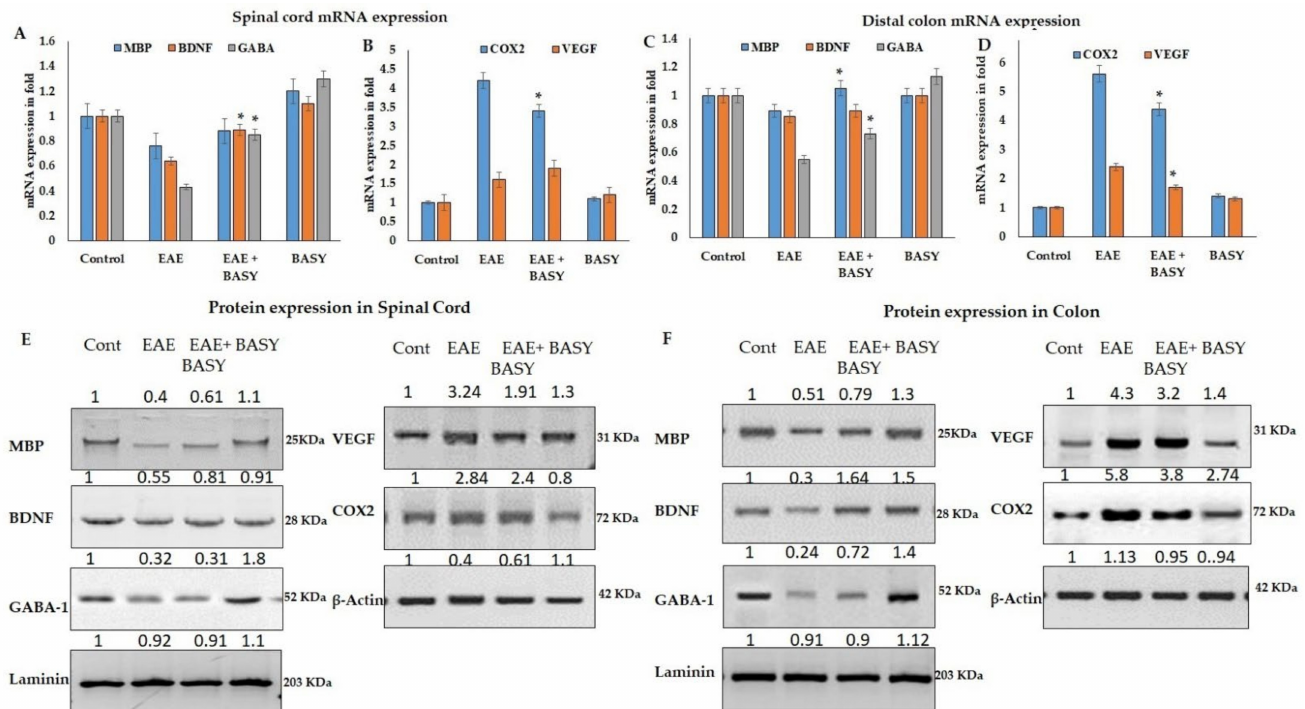
Figure 8. Various markers and neurotropic factors regulated by BASY in MOG-induced EAE mice: ( A ) mRNA expression of MBP, BDNF, and GABA in the spinal cord of MOG-immunized mice. ( B ) mRNA expression of COX-2 and VEGF in the spinal cord of MOG-immunized mice. ( C ) MBP, BDNF, GABA, COX-2, and VEGF protein expression was examined by immunoblot and densito- metry analysis in the spinal cord and was normalized with laminin and actin as internal controls. ( D ) mRNA expression of MBP, BDNF, GABA, and COX-2, VEGF in the colon of MOG-immunized mice. ( E , F ) MBP, BDNF, GABA, COX-2, and VEGF protein expressions were examined by immunoblot and densitometry analysis in the colon and normalized with actin and laminin as internal controls. Results are presented as mean ± SEM (n = 3). When comparing MOG to MOG+BASY